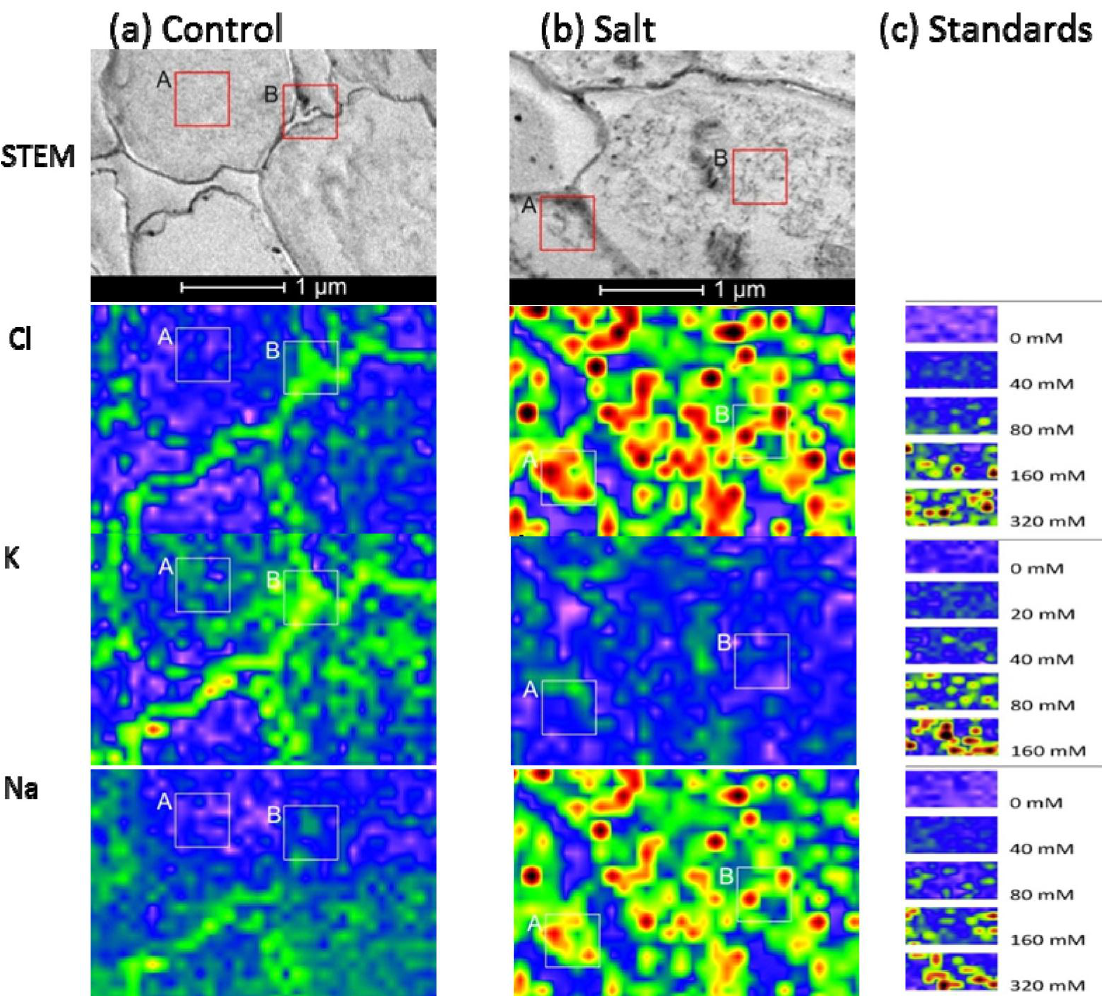
Figure 4. Representative STEM images and elemental images of root cortex in control ( a ) and NaCl-treated P. euphratica ( b ). For X-ray imaging, the area measured in root cortical cells depended on the cell structures of interest. The spatial resolution ranged from 50 nm  50 nm to 100 nm  100 nm. Elemental images of 5% agar standards ( c ) were acquired at the same resolutions. The maxima were set to 1000 for Na + and Cl − and 500 for K + ; the minima were set to 30 for Na + , 25 for Cl − , and 10 for K + . Frames A and B were used to calculate the mean intensities (Table